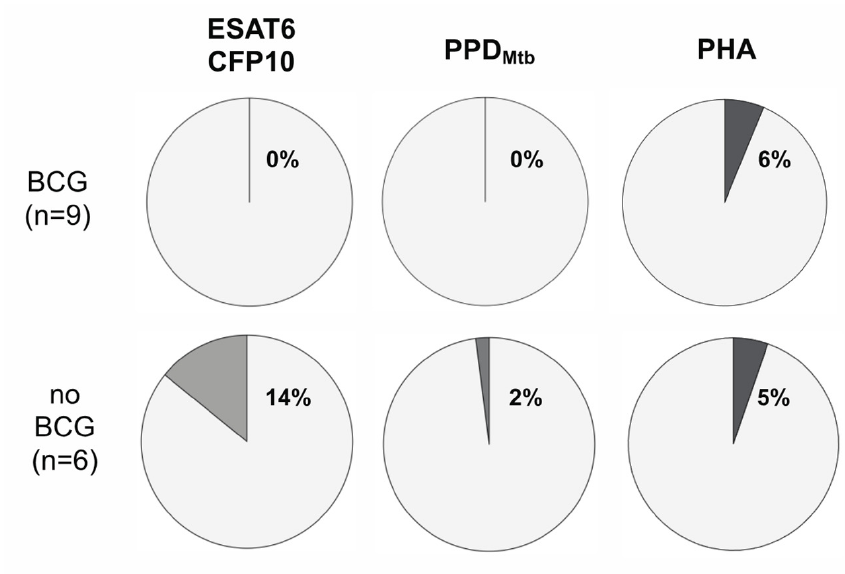
Figure 3. CD38 expression of M. tuberculosis -specific IFN- γ -positive CD4 + T-cell proportions between BCG-vaccinated and non-BCG-vaccinated children at BL. Proportions of CD38 + cells within the population of CD4 + IFN- γ -expressing ESAT6/CFP10-specific T-cells at BL are shown as pie charts for study groups of BCG-vaccinated ( n = 9) and non-BCG-vaccinated ( n = 6) children. Median values are depicted (dark gray for CD38 + ; bright gray for CD38 − ).